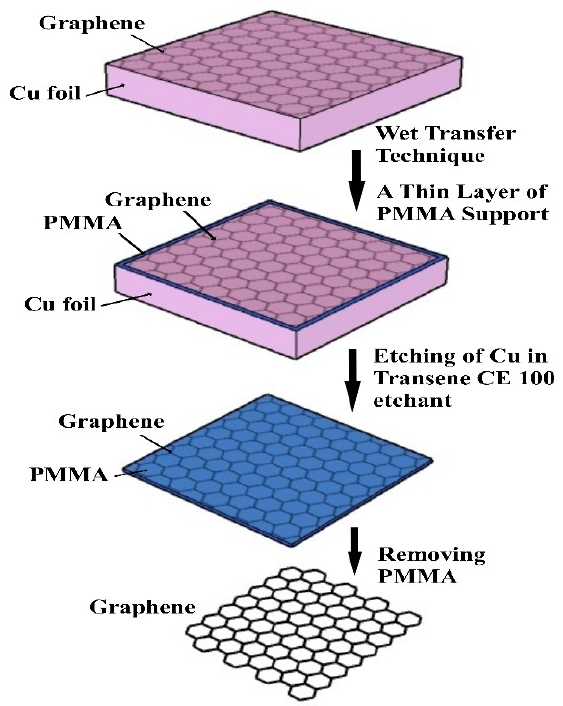
Figure 1. A schematic illustration of graphene transfer.